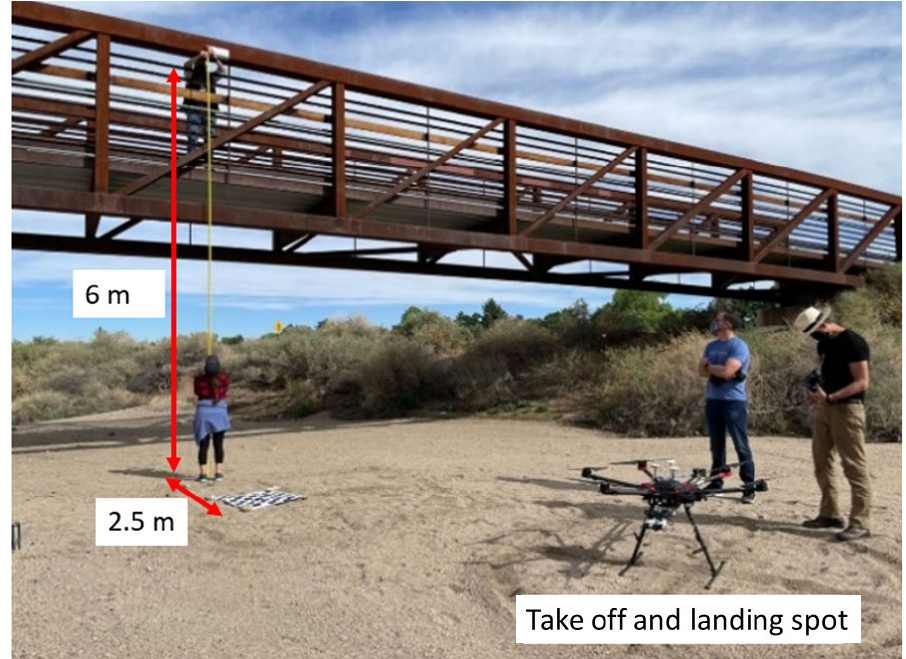
Figure 5. Arroyo Del Oso Park: Test team at the bridge site; NASIMI II in foreground.